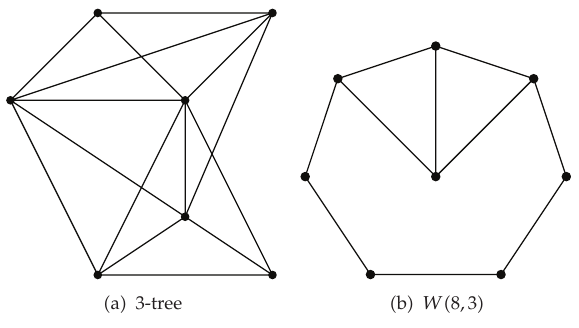
Figure 1: The graphs 3-tree and W (cid:6) 8 , 3 (cid:7)